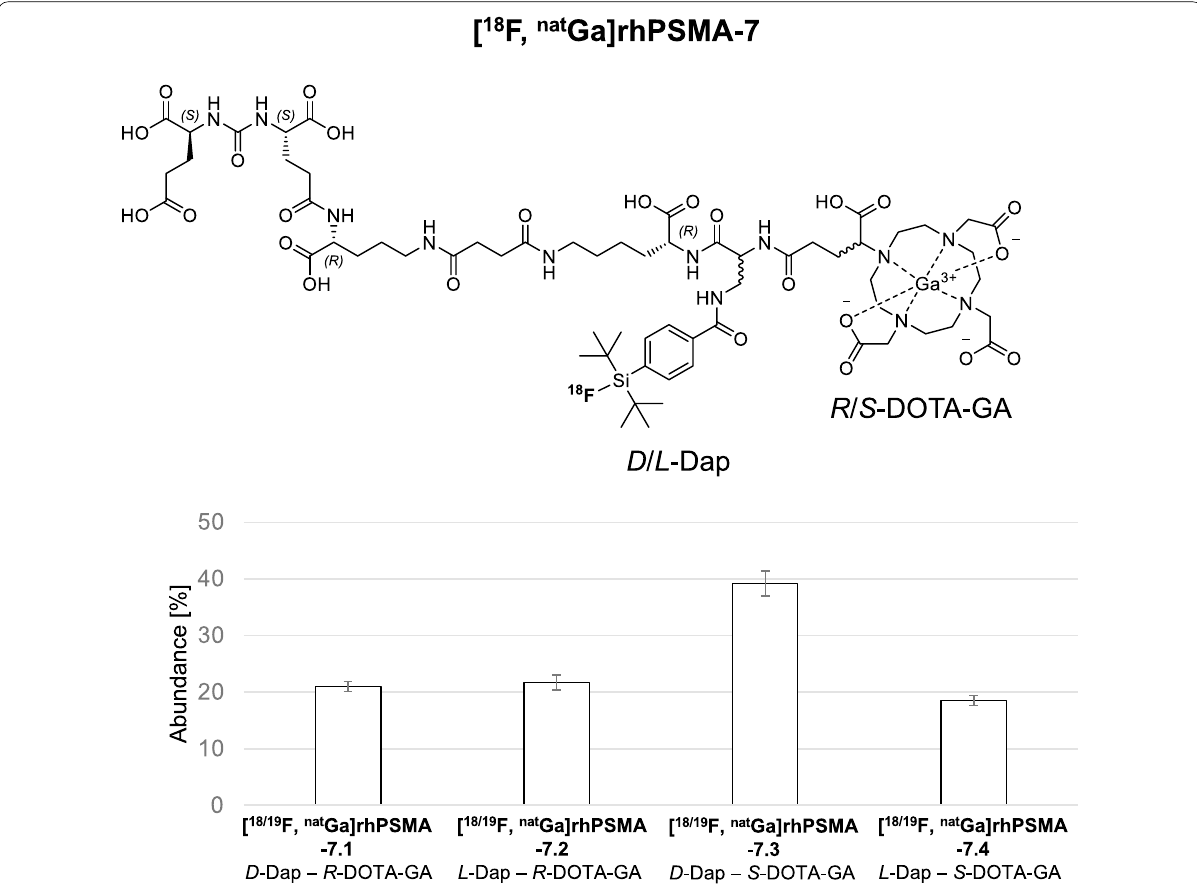
Fig. 1 Diastereomeric mixture [ 18 F, nat Ga]rhPSMA‑7 is composed of the four isomers [ 18 F, nat Ga]rhPSMA‑7.1 to ‑7.4, differing in the stereoconfiguration of diaminopropionic acid ( D- / L ‑Dap) and DOTA‑GA ( R ‑/ S ‑DOTAGA). The abundance of the diastereomers could be determined by HPLC‑analysis of retained samples of previously produced batches of the diastereomeric mixture, [ 19 F, nat Ga]rhPSMA‑7